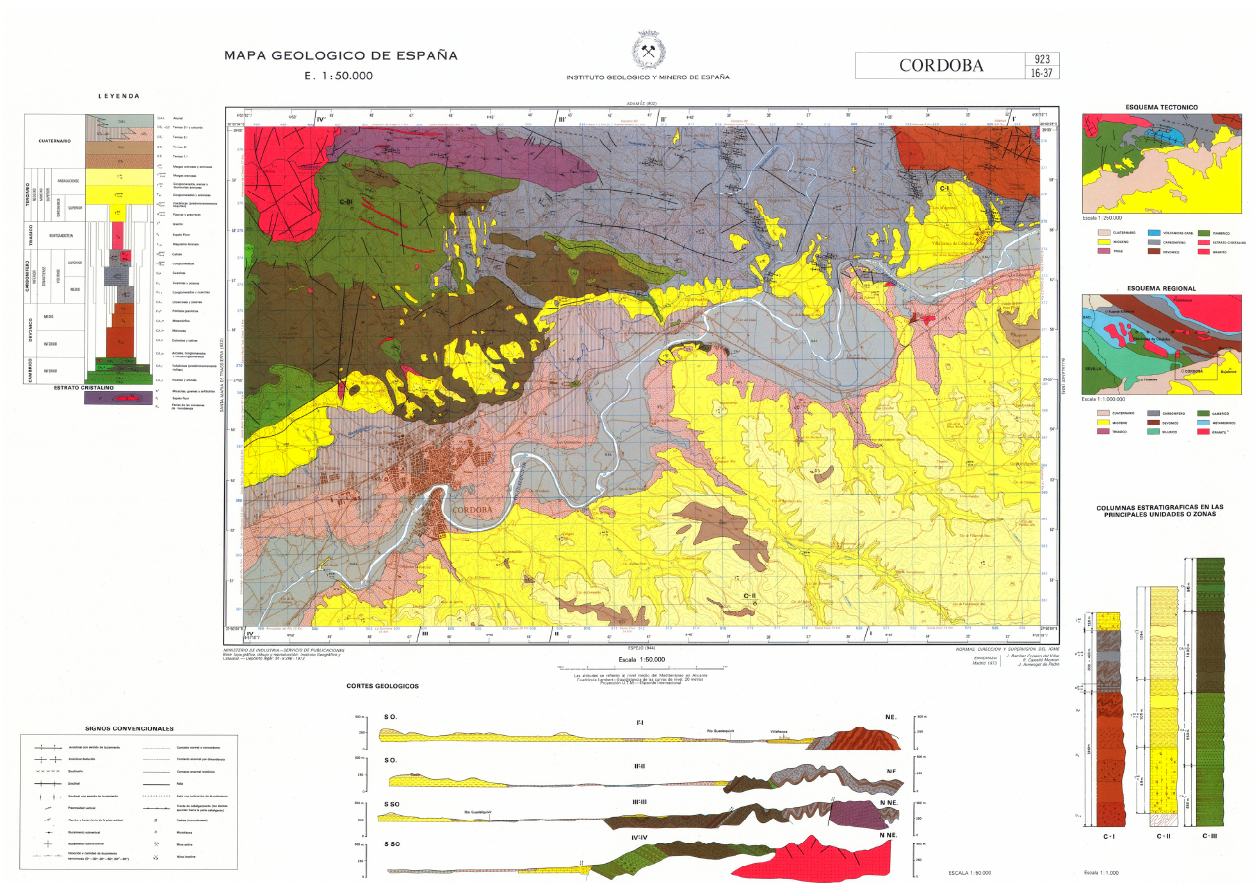
Figure 1. Geological map of Spain, scale: 1:50,000. Geological Section of Cordoba and the central Guadalquivir Valley. In yellow, the Miocene mountains to the east and west of the river valley. In grey, the quaternary fluvial terraces of the Guadalquivir River. ©Instituto Geológico y Minero de España (IGME).